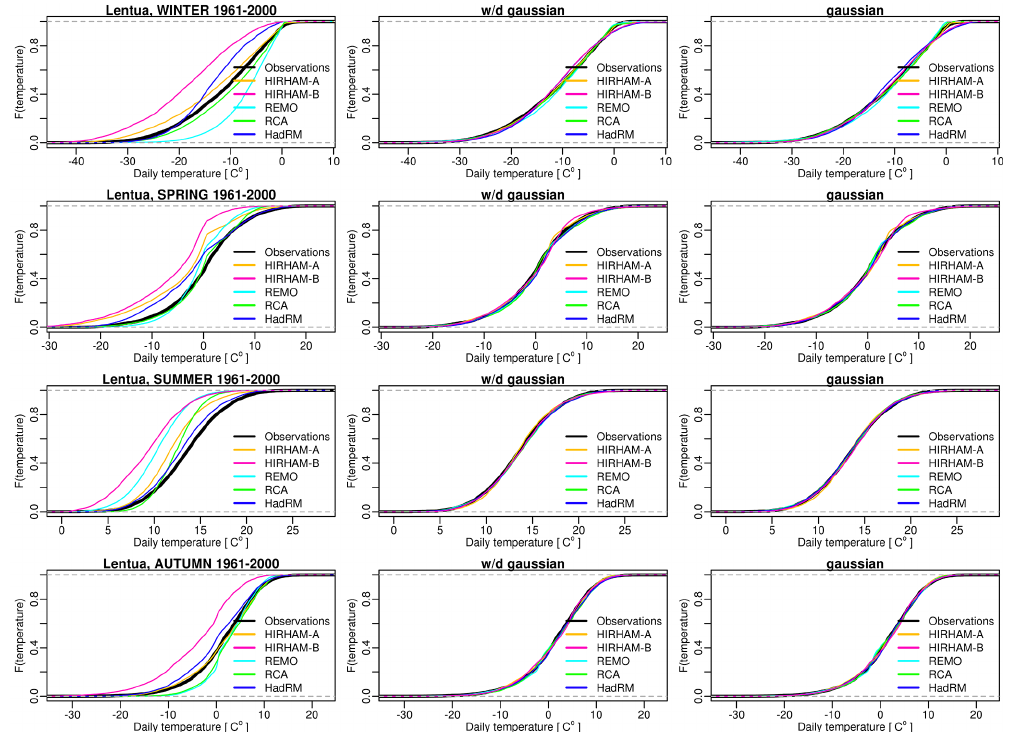
Figure 5. Cumulative distribution functions for daily temperature in Lentua catchment during the control period 1961–2000. Observations and uncorrected RCM data in left column, daily RCM temperatures adjusted with wet–dry state separation (w–d Gaussian) are presented in middle column and without wet–dry separation (Gaussian) in right column. Winter is shown in first row, spring in second row, summer in third row and autumn in bottom row. All the adjusted values closely follow the observed distribution and no big differences can be seen between the two bias correction procedures.